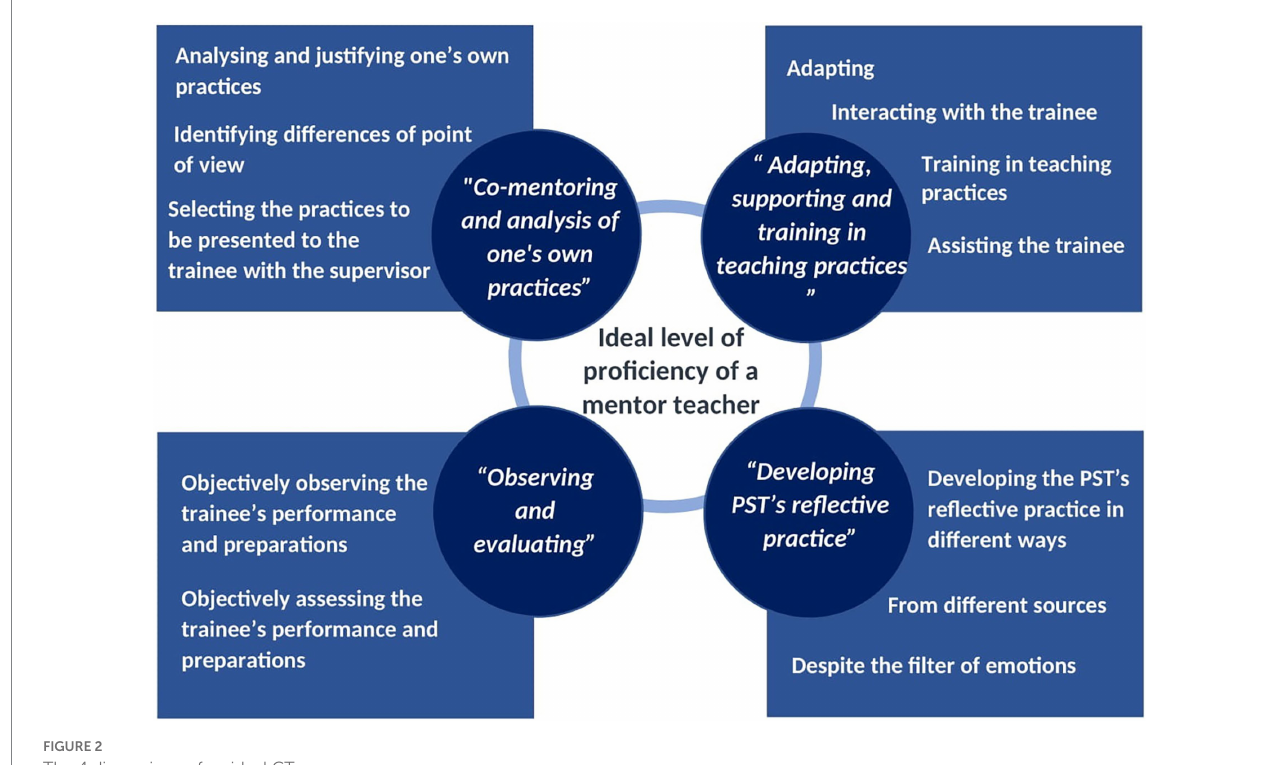
FIGURE 2 The 4 dimensions of an ideal